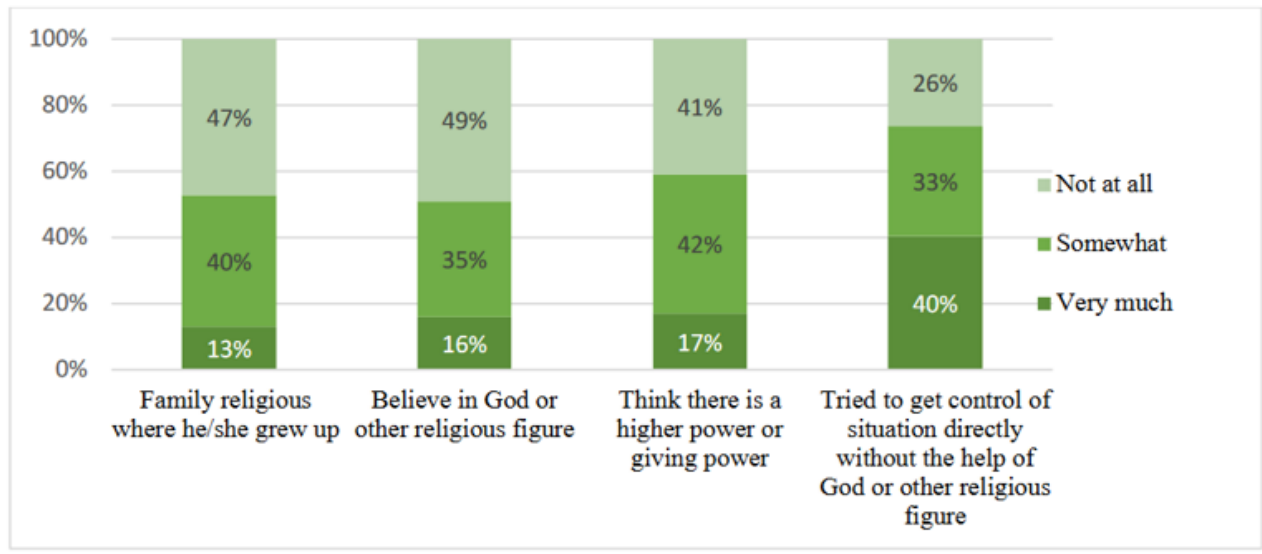
Figure 3. Religious and spiritual background and thinking, by percentage.